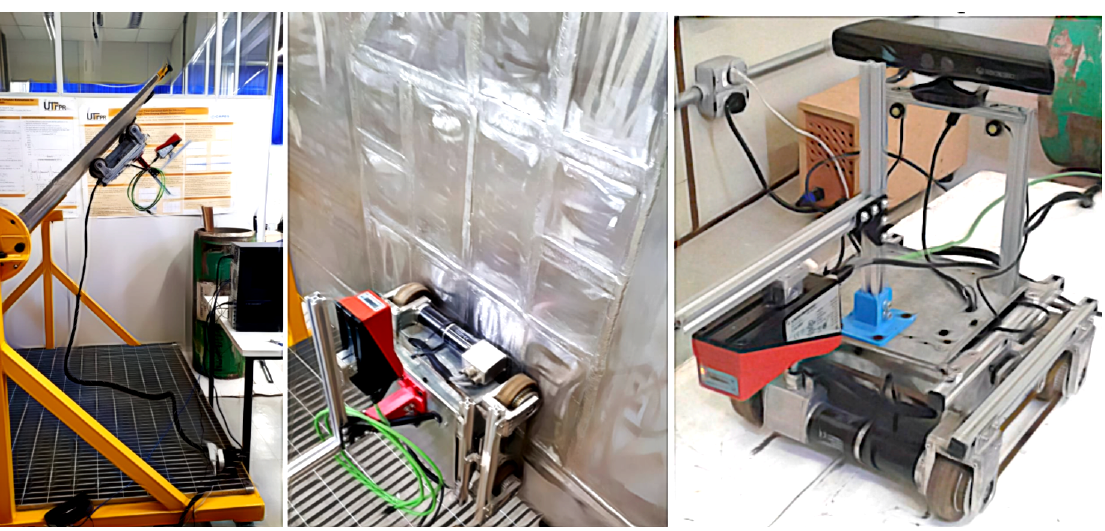
Figure 2. Autonomous Inspection Robot 1 (AIR1). A robot conceived/developed to inspect weld beads in storage tanks containing liquefied petroleum gas. A profile sensor, facing downwards, is positioned in front of the